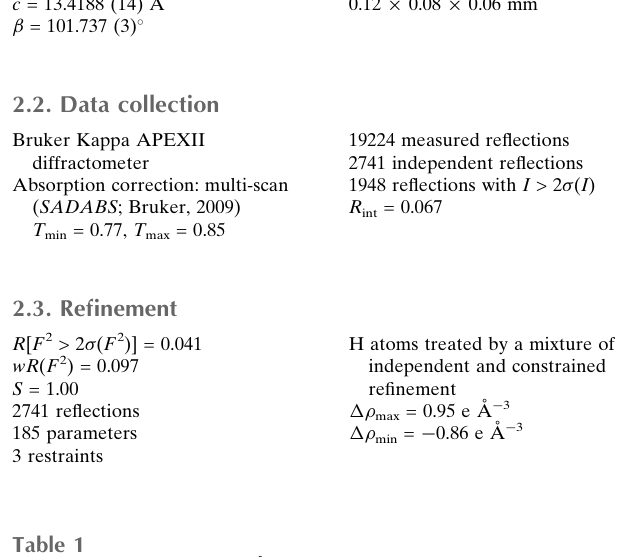
Hydrogen-bond geometry (A˚ , (cid:4)